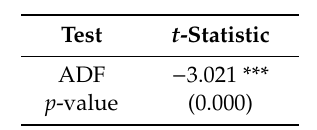
Table 3. Results of the Kao cointegration